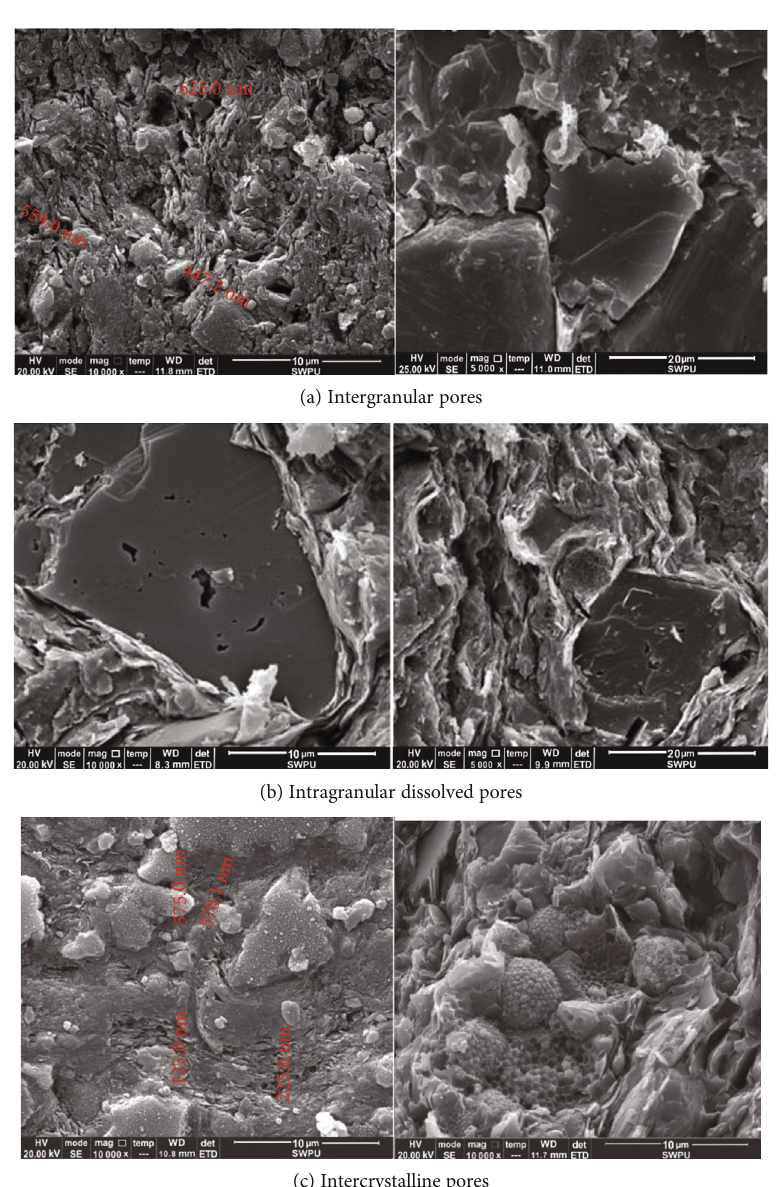
Figure 2: SEM images of shale inorganic pores [1] (the sample from Changning area of Weiyuan, Sichuan,